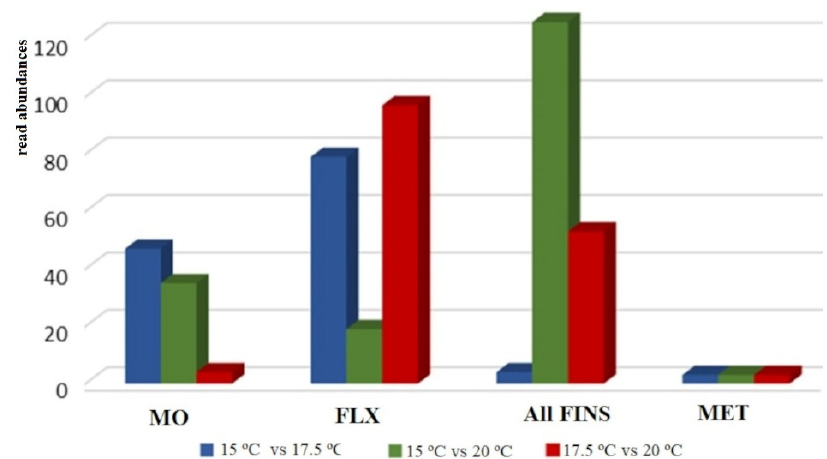
Figure 4. Overview of differentially expressed miRNA with significance threshold p -adj. < 0.05 and log2FC >|1| at the stages mouth opening (MO), flexion (FLX), all-fins (Fins), and metamorphosis (Met) (n = 3 – 4). The relative abundances are shown on the y-axis.